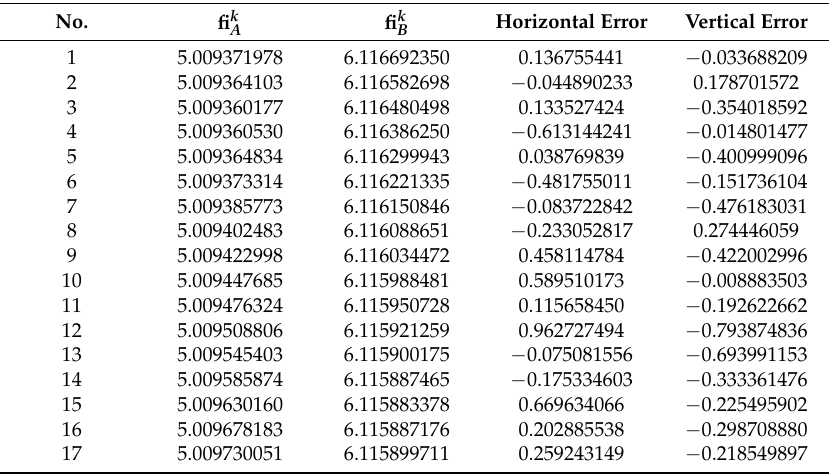
Table 3. Azimuth angles and positioning errors in the turning using DCPE